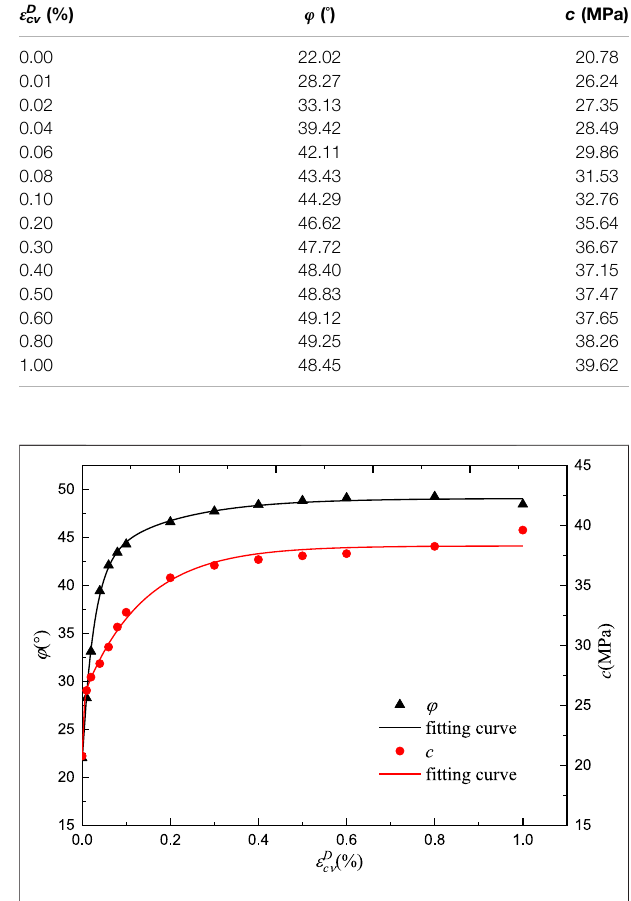
FIGURE 8 | Evolution law of strength parameters φ , c with ε D cv